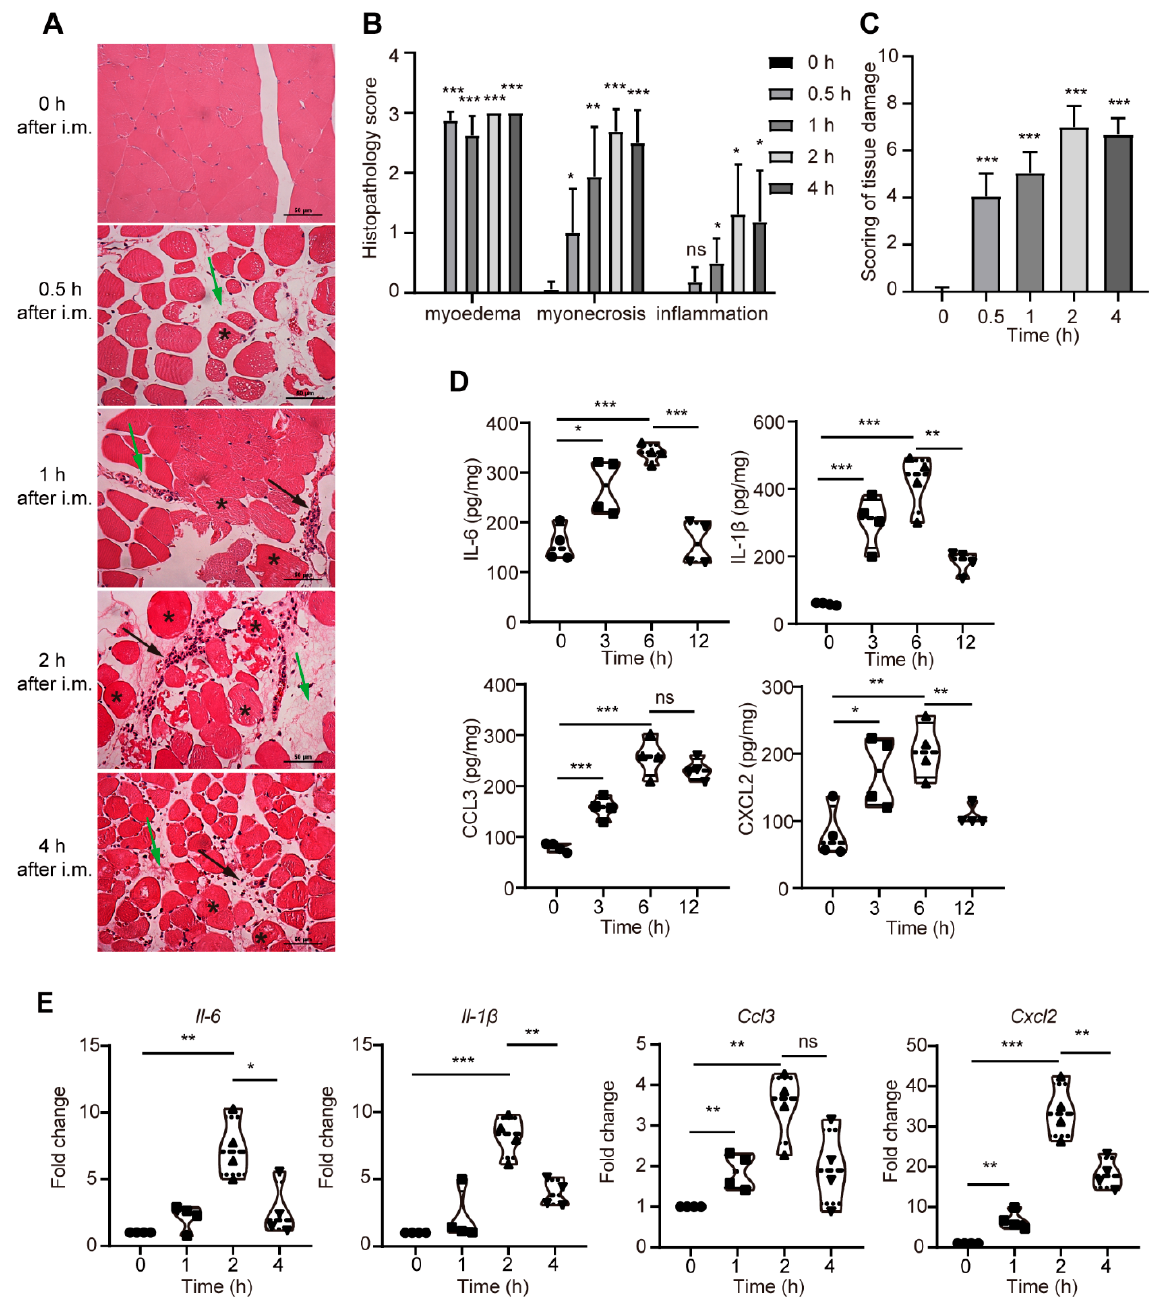
Figure 1. The intramuscular injection of PD led to tissue damage and inflammatory response in mouse quadricep muscles. ( A ) The quadricep muscle sections were stained using H&E. The light photomicrographs shown were representative of quadricep muscle sections from four mice per group. Edema (green arrows); inflammation, the muscle fibers are surrounded by inflammatory cells, mainly neutrophils (black arrows); and myonecrosis (asterisk). Scale bars: 50 μ m. ( B ) Histopathology score of myoedema, myonecrosis, and inflammation. ( C ) Quantification of muscle tissue damage by the total muscle histopathology score. ( D ) The levels of IL-6, IL-1 β , CCL3, and CXCL2 in quadricep muscles injected i.m. with 50 μ g PD by ELISA. ( E ) The gene expression levels of Il-6 , Il-1 β , Ccl3 , and Cxcl2 in quadricep muscles injected i.m. with 50 μ g PD by RT-qPCR. Data were presented as mean ± SD ( n = 3, the number of replicates, the same below). (*) p < 0.05, (**) p < 0.01, (***) p < 0.001, ns not significant.